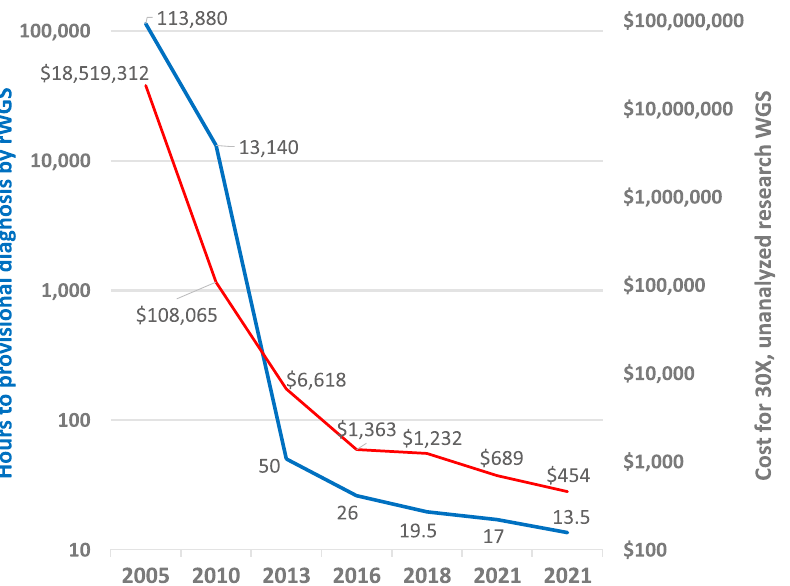
Fig. 5 Decreasing cost of research WGS (red line) and time to provisional diagnosis of rapid, clinical WGS (blue line) of WGS, 2005 – 2021. 13, 15 – 17 (https://www.genome.gov/about-genomics/fact-sheets/Sequencing-Human-Genome-cost). Source data are provided as a Source Data fi